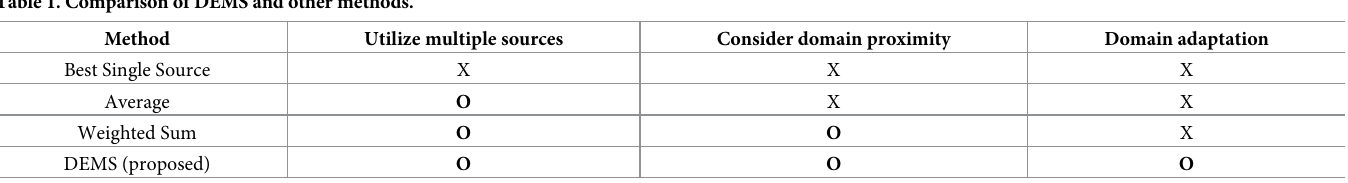
Table 1. Comparison of DEMS and other